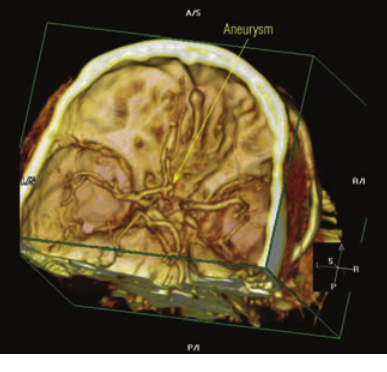
Figure 2. Computed tomography angiog- raphy showing a 5 mm aneurysm arising from the anterior communicating artery. The aneurysm had not been detected until 3D reconstruction was performed.